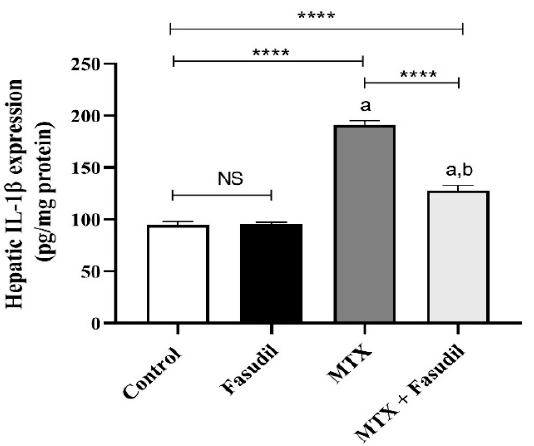
Figure 5. Effect of fasudil on IL-1 β expression. Results are presented as mean ± SEM ( n = 8); a: significant difference from the control group ( p < 0.05); b: significant difference from the MTX group ( p < 0.05). **** p < 0.0001. NS, non-significant.